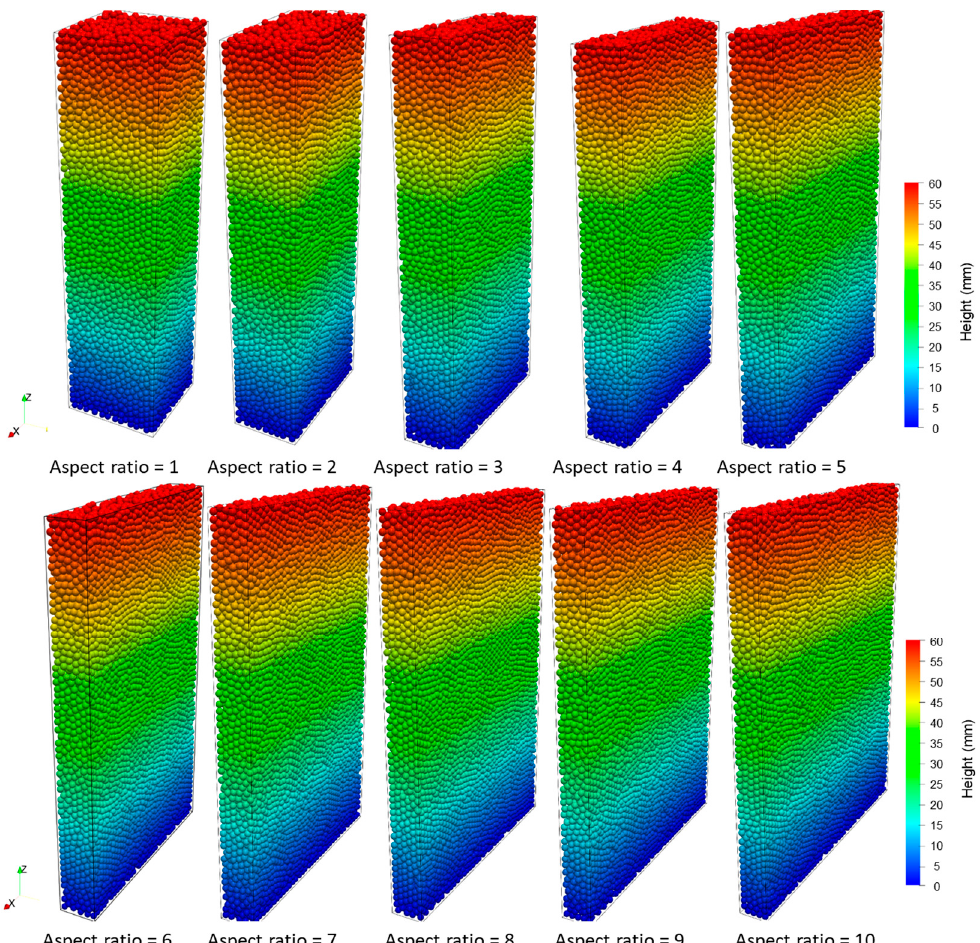
Figure 3. Rectangular pebble beds with aspect ratios of 1–10 and cross-sectional area of 225 d 2 .